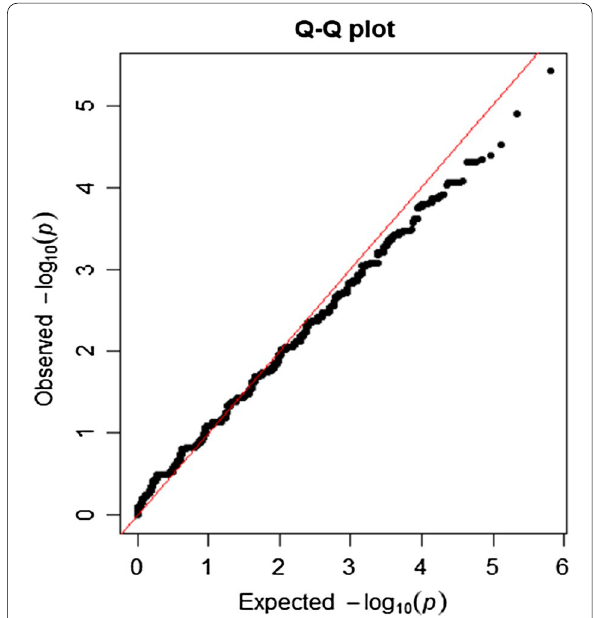
Fig. 2 Q–Q plot. The plot shows the observed of the tested SNPs (black symbols) plotted against the theoretical expected log 10 p -values under the null hypothesis (red −